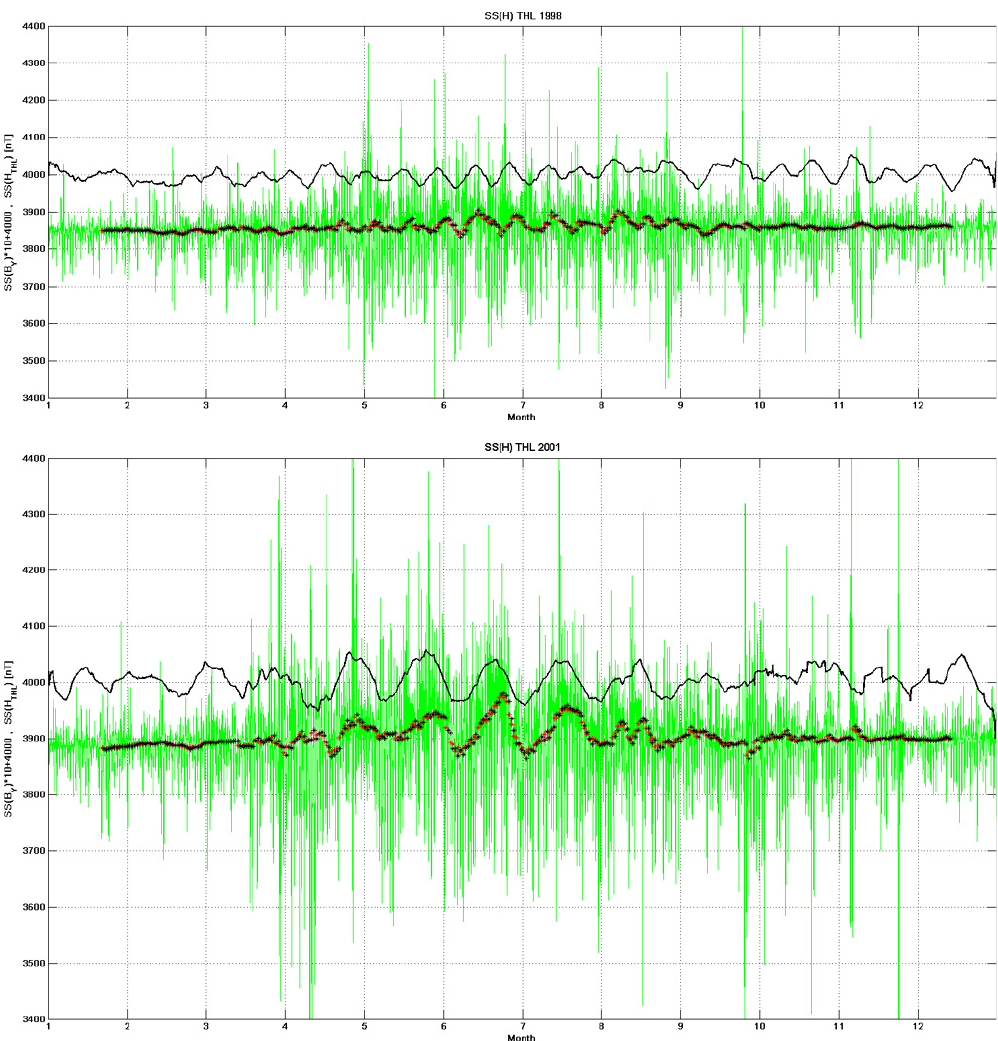
Fig. 7. The SS effect derived in the H-component observed at station Thule in 1998 (a) and 2001 (b) . The actual variation of the ground H- component is shown by the green line, whereas black asterisks present the extrapolated SS structure obtained by the extrapolation procedure when all data are available till the examined day ( n = 0), and red asterisks present the interpolated SS structure derived under the condition that the examined day is in the middle of a gap in the time interval. The actual variation of the IMF B y component, measured by ACE spacecraft, is shown by the thin black